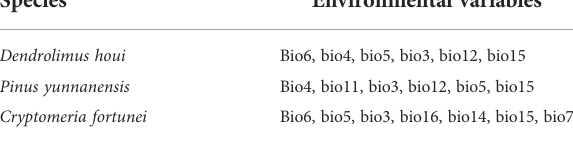
TABLE 1 Major bioclimatic variables affecting the habitat distribution of Dendrolimus houi and its hosts, Pinus yunnanensis and Cryptomeria fortunei , in